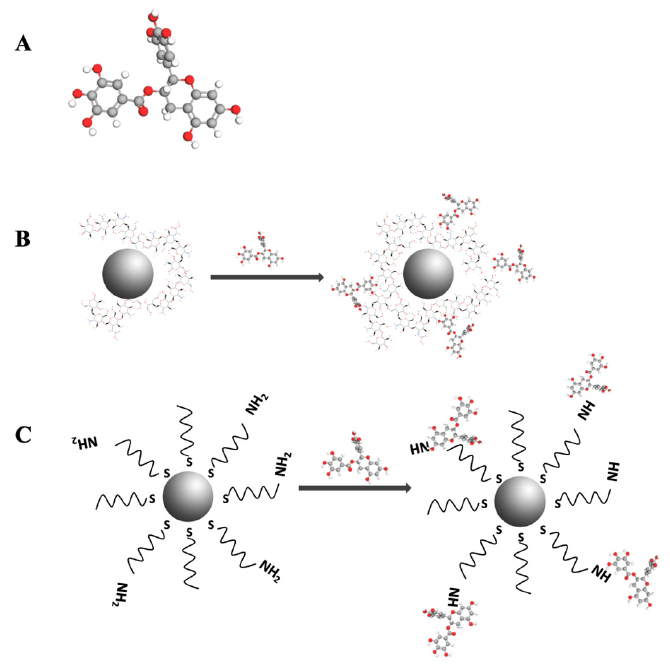
Figure 2. ( A ) Chemical structure of EGCG; ( B ) Scheme of nanoconjugate EGCG-ChAuNPs; ( C ) Scheme of nanoconjugate EGCG-CystAuNPs.